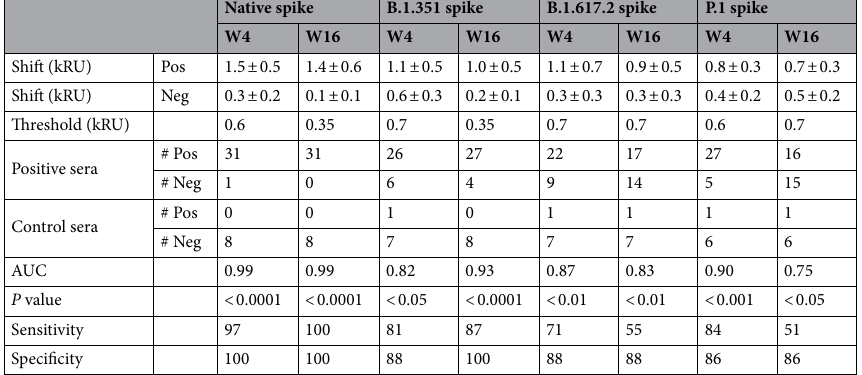
Table 2. SPR assay for the detection of human IgG targeting the native, B.1.351, B.1.617.2, and P.1 spike proteins using serum from variant-naïve, SARS-CoV-2-positive individuals at weeks 4 and 16 post-diagnosis.